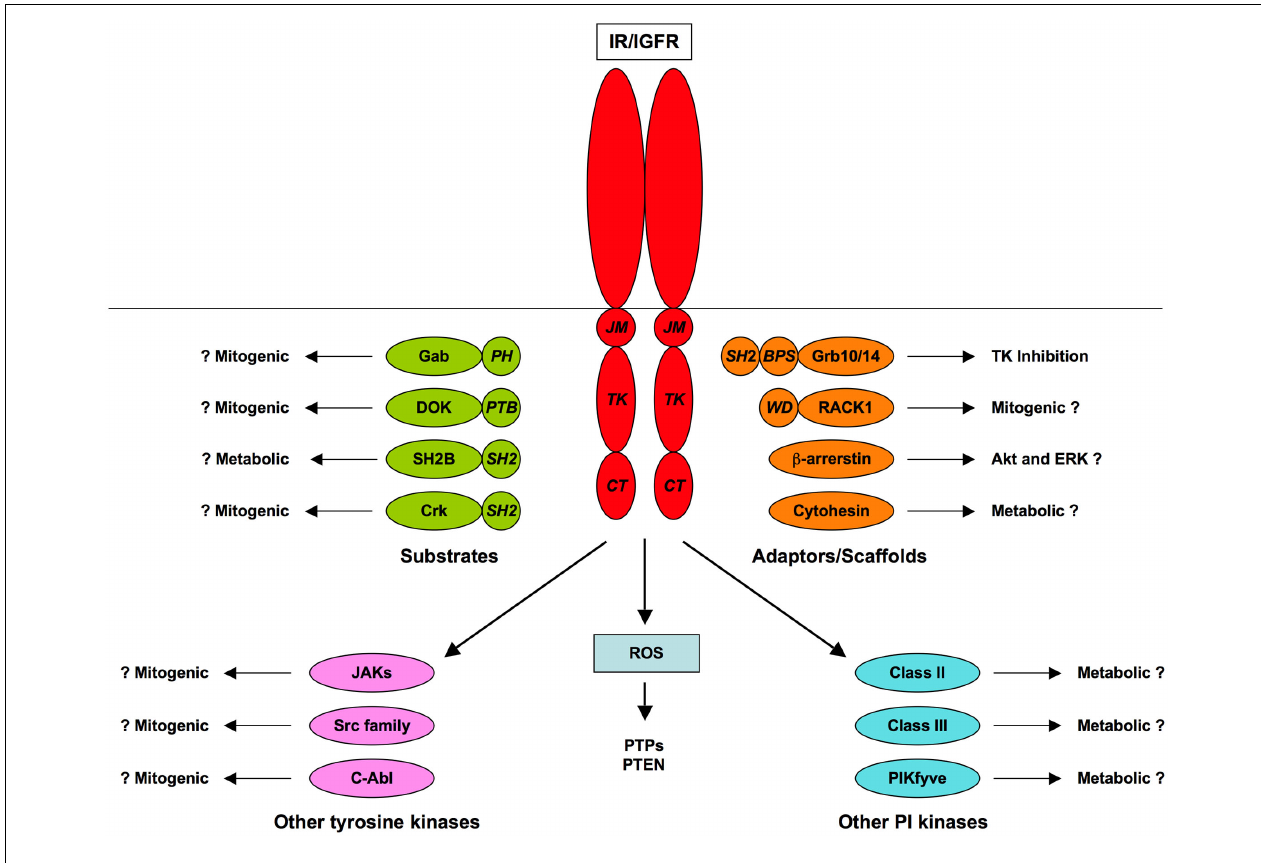
juxtamembrane; TK , tyrosine kinase; CT , carboxyl-terminal; PTB , phosphotyrosine-binding; PH , pleckstrin homology, SH2 , Src homology-2; BPS , between PH and SH2; WD ,W-D (Trp-Asp) dipeptide